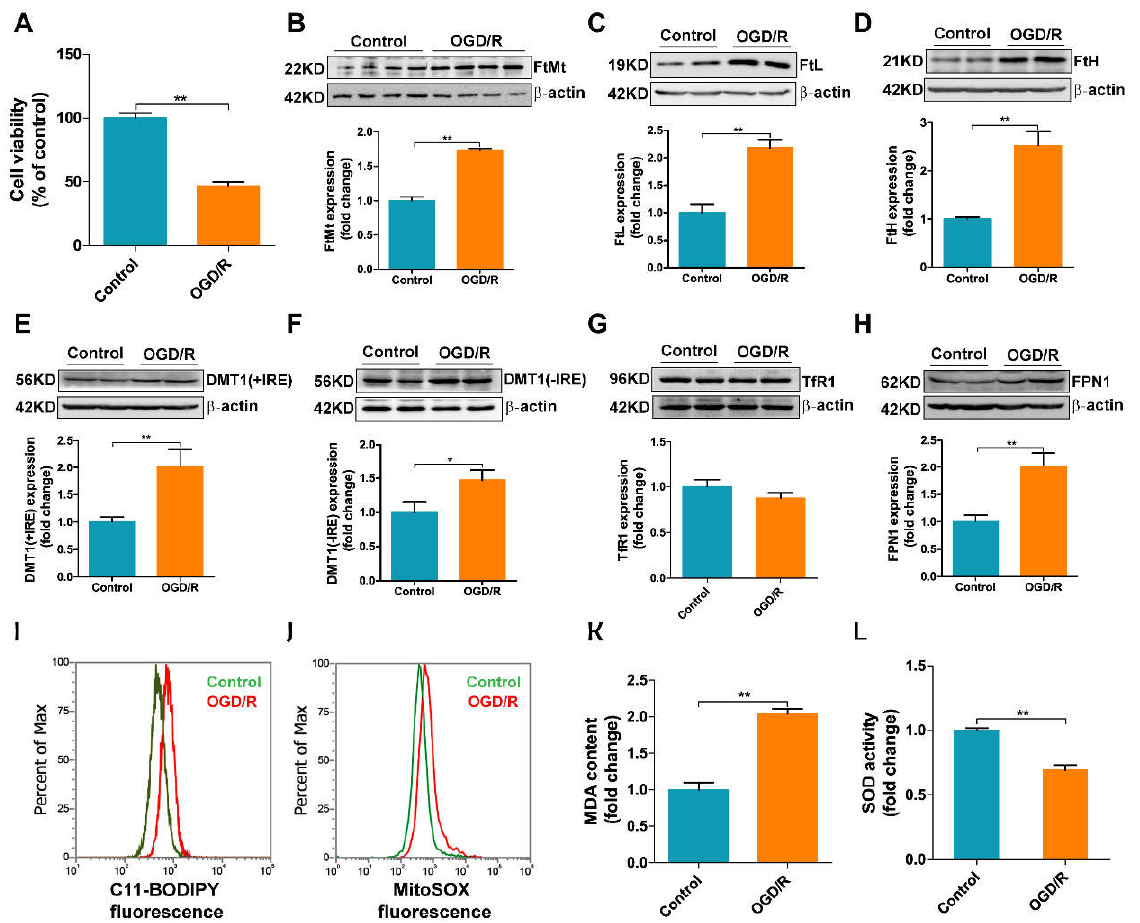
Figure 5. OGD/R induces iron dysregulation and oxidative stress in bEnd.3 cells. bEnd.3 cells were subjected to OGD for 9 h and reperfusion for 2 h. ( A ) Cell viability was determined using the MTT assay ( n = 6). The levels of ( B ) FtMt, ( C ) FtL, ( D ) FtH, ( E ) DMT1(+IRE), ( F ) DMT1(-IRE), ( G ) TfR1 and ( H ) FPN1 were analyzed by western blot and the results were normalized to the β -actin levels. The data are expressed relative to the mean value in the control group ( n = 4). ( I ) Lipid ROS and ( J ) mitochondrial ROS production was assessed in bEnd.3 cells after OGD/R insult by flow cytometry using C11-BODIPY and MitoSOX, respectively; representative data from one of three experiments are shown. ( K ) MDA and ( L ) SOD activity were analyzed by commercial assays and the data are expressed relative to the mean value in the control group ( n = 3). The results are presented as the mean SEM. * p < 0.05, ** p < 0.01.